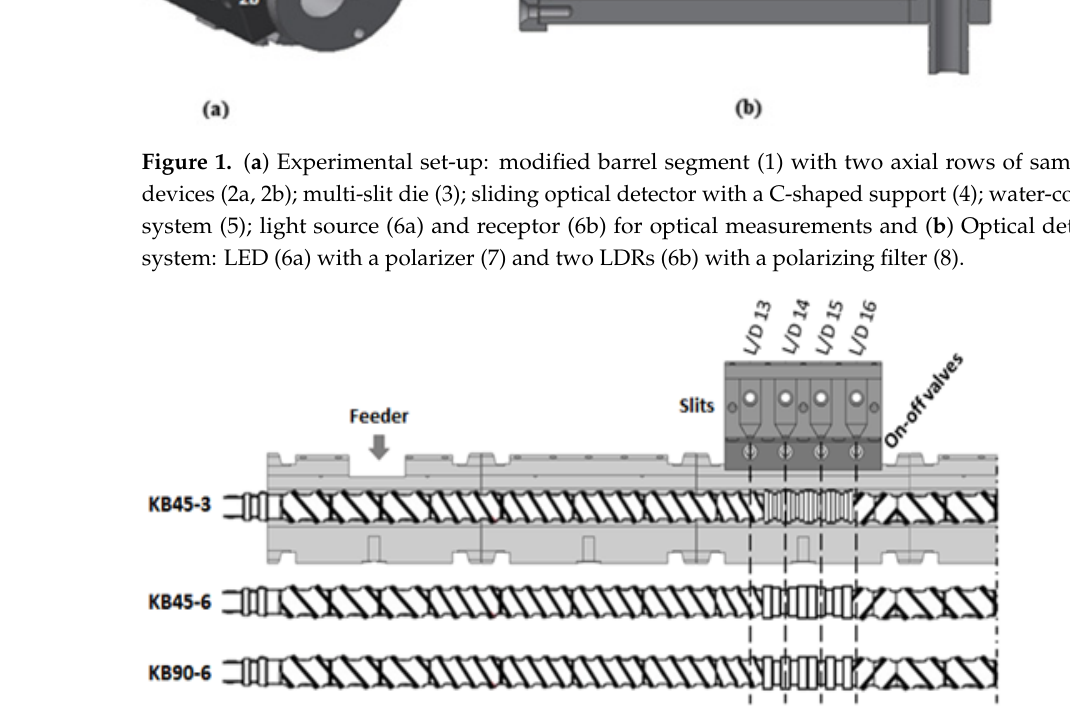
Figure 2. Screw profiles containing a 60 mm long mixing zone with different geometries: KB45-3— four kneading blocks with positive 45° stagger, each containing five 3 mm thick disks; KB45-6—two kneading blocks with 45° positive stagger, each containing five 6 mm thick disks; KB90-6—two kneading blocks with neutral 90° stagger, each containing five 6 mm thick disks.